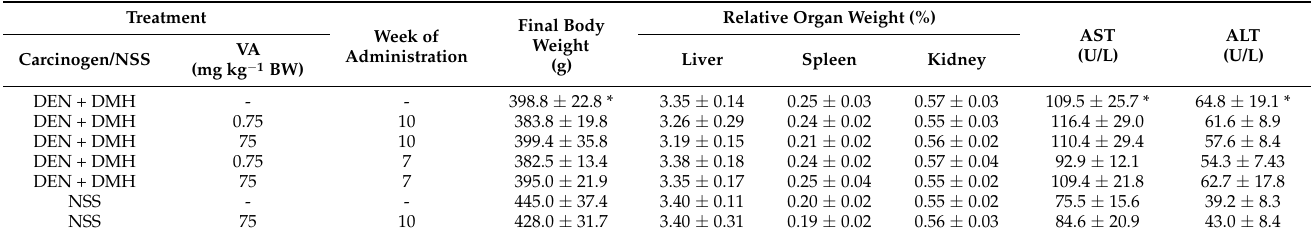
Table 1. The effect of VA on relative organ weight and activities of serum AST and ALT in DEN- and DMH-initiated rats. Values expressed as mean ± SD.